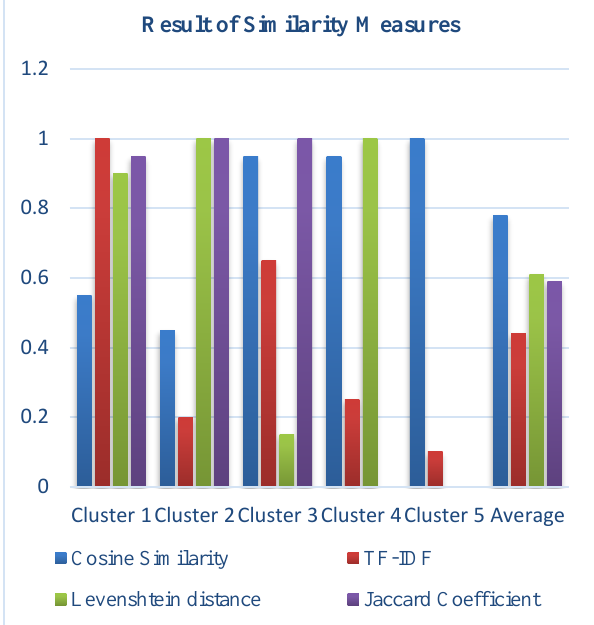
Figure 4 Result of Similarity Measure after Pre-processing Figure 4 represents the average result of five clusters by utilized four various similarity measures after